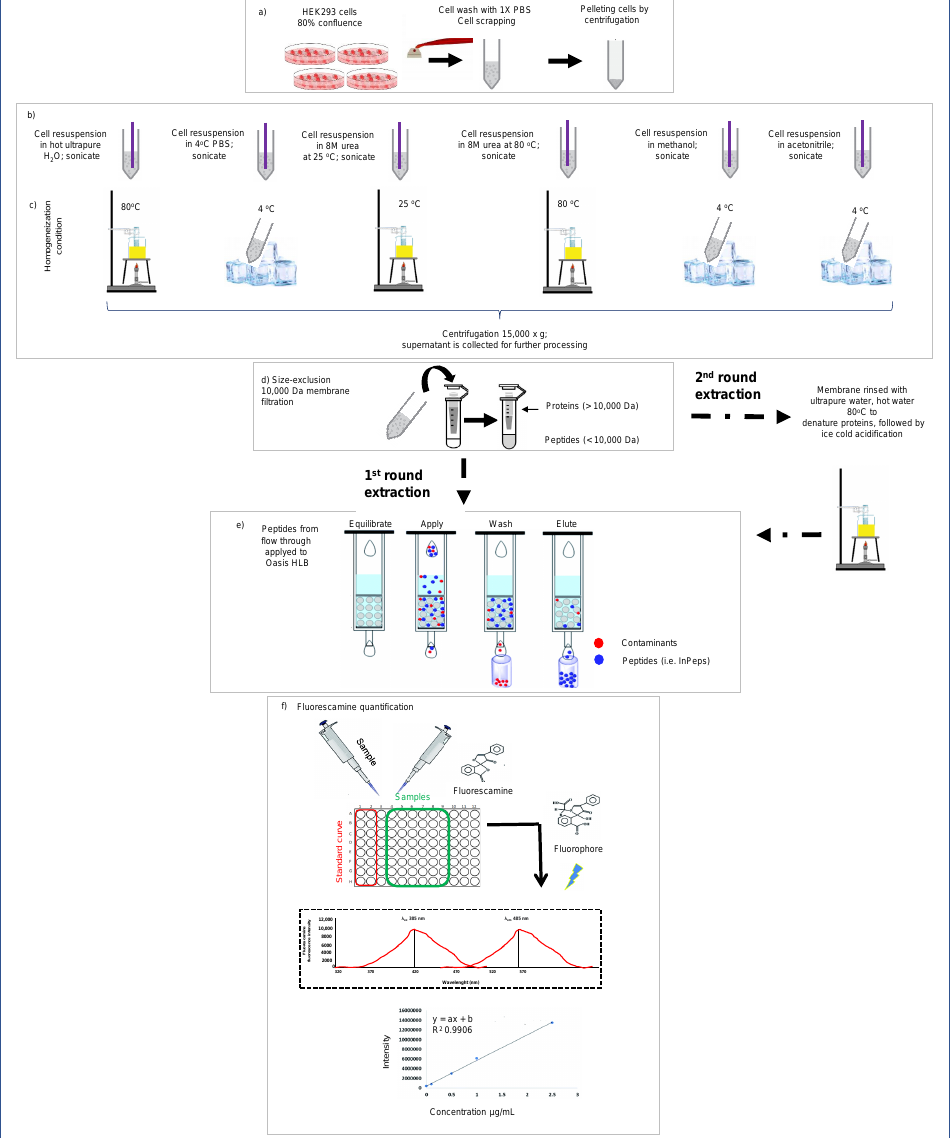
Figure 1. Summarized scheme of InPeps extraction from HEK293 cells. ( a – c ) Sub-confluent HEK293 cell cultures were resuspended and homogenized in defined conditions, sonicated, centrifuged, and placed into Amicon ® Ultra 4 mL low-binding 10,000 Da size-exclusion filter membranes (Merck- Millipore, Burlington, MA, USA). ( d ) The flowthrough was collected and stored at − 20 ◦ C before quantification; InPeps present on this material were considered from “first round” of extraction. The material retained in the 10,000 Da size-exclusion filter membranes was removed by rinsing with ultrapure water, heated at 80 ◦ C for 5 min to denature proteins, acidified with 6N HCl after been ice cold, and stored at − 20 ◦ C before quantification; InPeps present on this material were considered “second round” of extraction. ( e ) Stored samples were thawed on ice and applied to Oasis HLB columns for peptide purification as per manufacturer’s instructions. After being dried into a speed vacuum concentrator (Eppendorf, Hamburg, Germany) and resuspended in ultrapure water (60 µ L). ( f ) Fluorescamine was used for peptide quantification, as previously described [36,85]. Phosphate buffered saline, pH 7.4